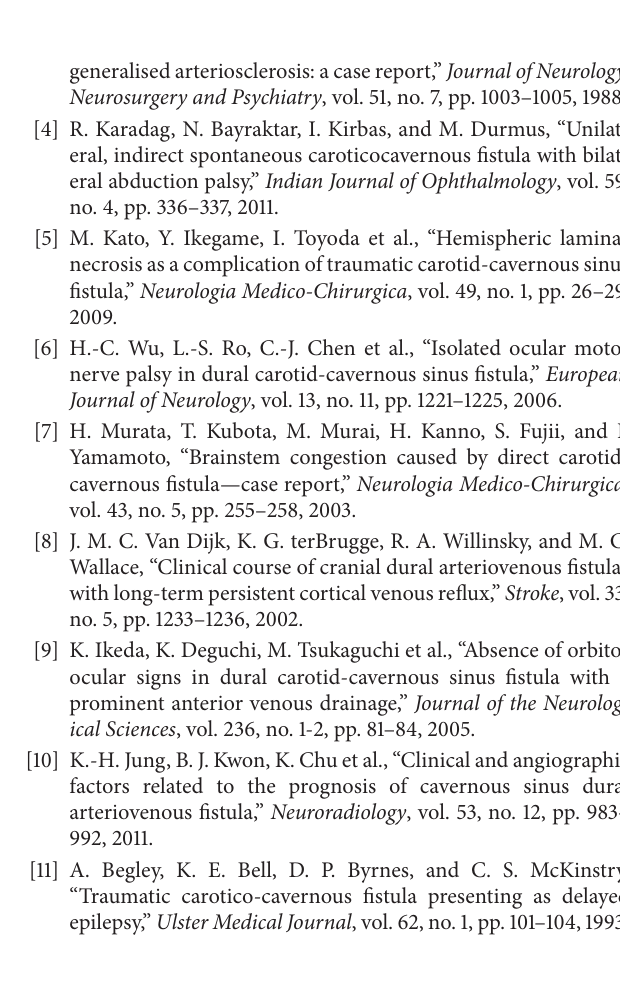
Figure 3: Early arterial phase of the lateral carotid angiography with the filling of the carotid sinus via the fistula ((a) white arrows) and lateral carotid angiogram with the fistula completely closed after transvenous coil embolization ((b) black